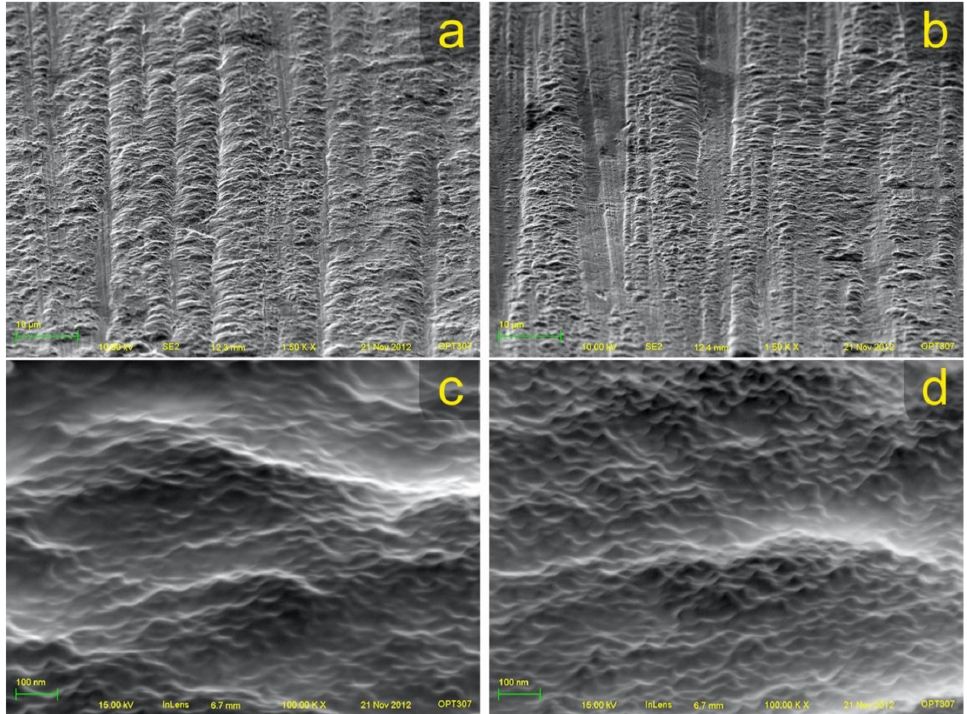
Figure 1. SEM images of the Ti surface ( a , c ) and the APTES-coated surface ( b , d ) showed similar surface morphology (1500 × and 100,000 × magnifications).